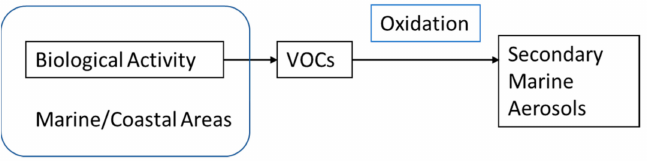
Figure 10. Secondary marine aerosols as a result of biological activity, impacts atmospheric particle composition [39].